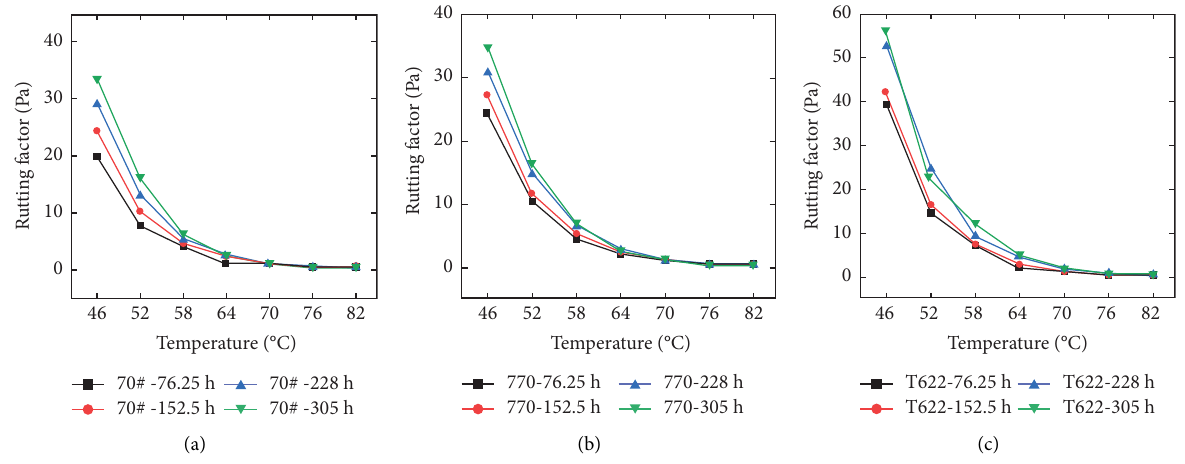
Figure 9: Rutting factor variation curves of diferent types of asphalt with UV aging time. (a) 70#. (b) T770. (c)